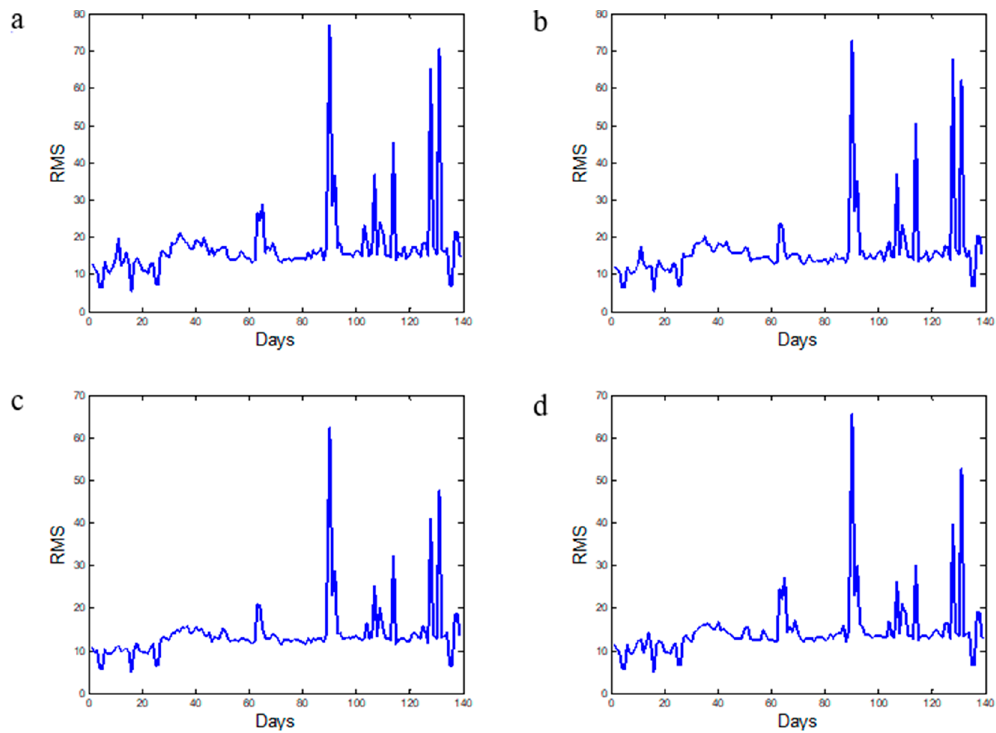
Figure 8. RMS feature calculated from MM operators for 0.9 T (T = 1/BPFI): ( a ) erosion; ( b ) dilation; ( c ) closing and ( d ) opening.